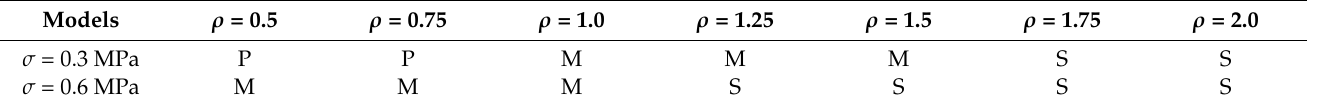
Table 4. Comparison of failure modes of all models ( η